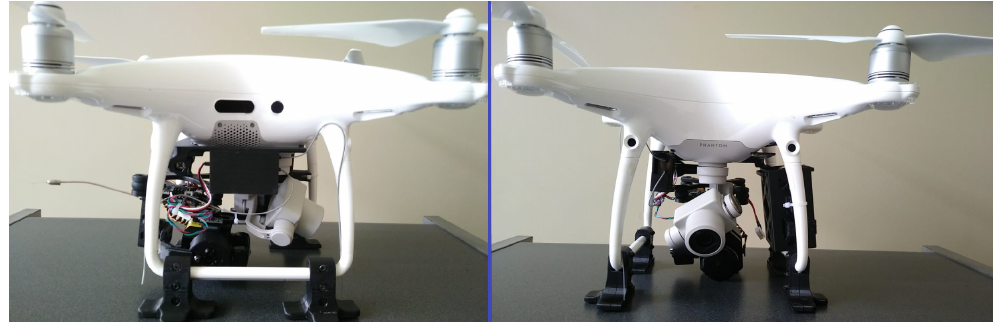
Figure 6. Side ( left ) and front ( right ) view of the UAV with infrared and RGB cameras used in the